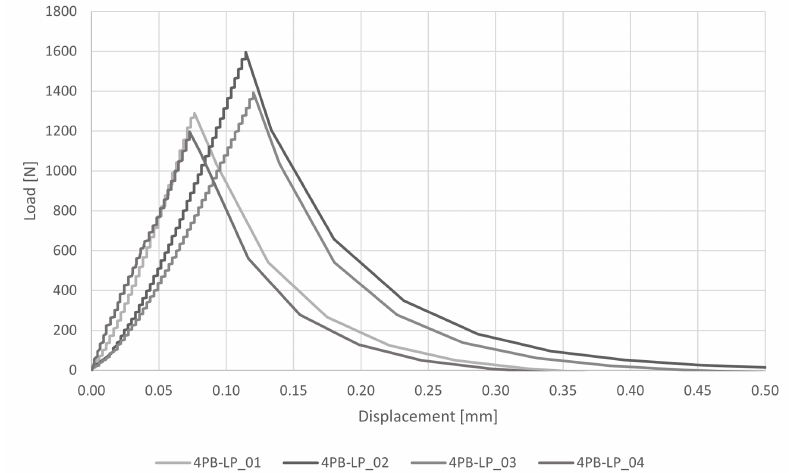
Figure 9. Load–displacement diagram for four-point bending tests